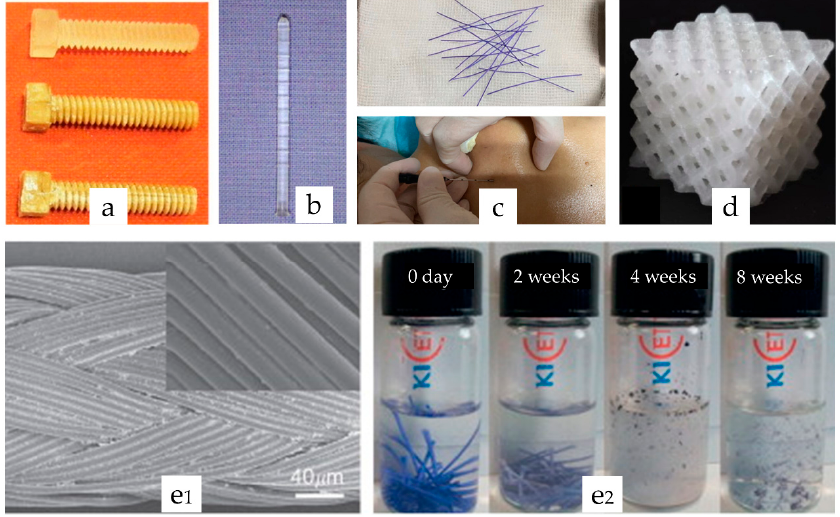
Figure 1. Biodegradable polymeric implants. ( a ) Bone fixation screws made of polylactic acid (PLA) with phosphate enforcement (reprinted from [9] with copyright permission). ( b ) Biodegradable 2